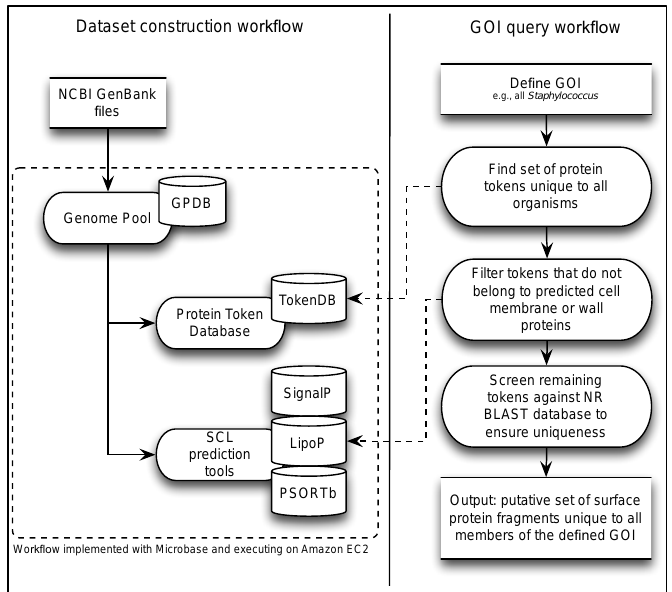
Figure 3: The GOI query workflow, ApID2, uses the datasets provided by the automated token generation and characterisation workflow, ApID1. A Group of Interest (GOI) is defined, based on the phenotype of a set of organisms of interest in a diagnostic context. The TokenDB is queried for any fragments of proteins that occur in all organisms defined in the GOI, but which do not occur in any other organism present in the NCBI RefSeq dataset. The parent proteins of this set of tokens are then identified. Any token that originates in a protein sequence that is not predicted to be located on the membrane or cell wall is excluded. Finally, BLAST-P is used to verify the remaining tokens against the NCBI’s non-redundant (NR) database.